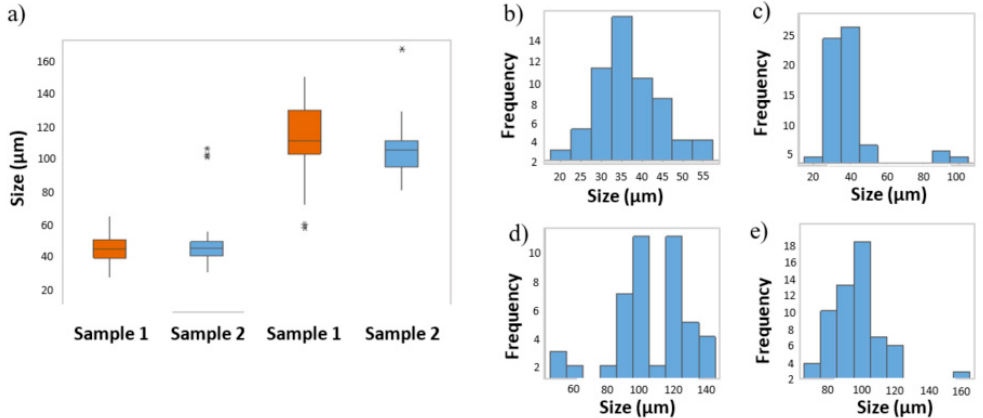
Figure 10. HIP’ed rods and paired parameters cracking in relation to normalised beam speed.